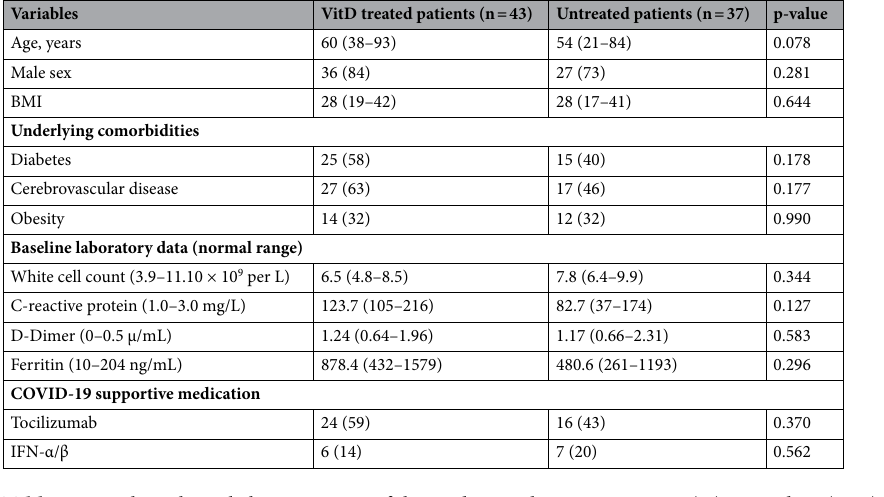
Table 1. Baseline clinical characteristics of the study population. Data are n (%) or median (IQR). BMI body mass index, CRP C-reactive